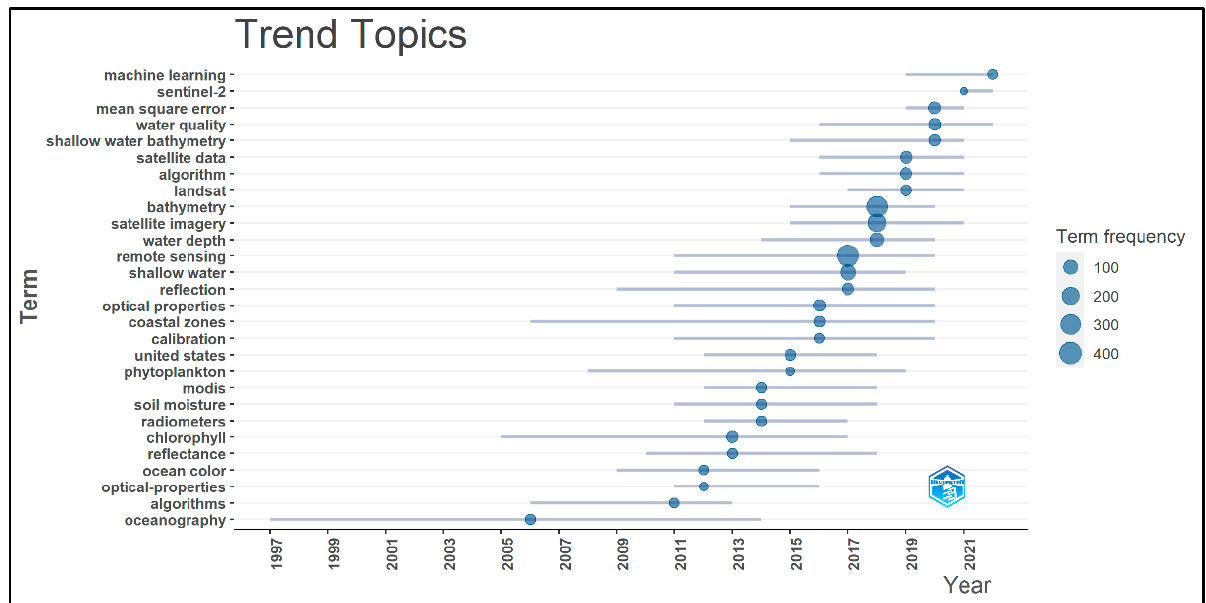
Figure 15. Trend topics for SDB (WoSCC and Scopus databases).